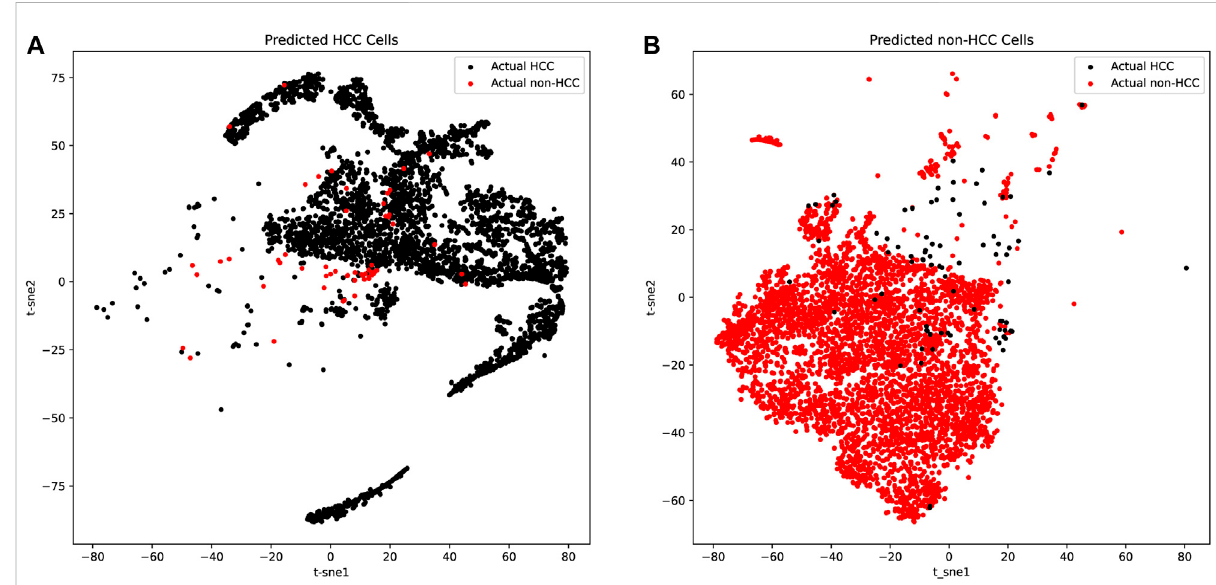
FIGURE 3 The t-SNE plots of predicted HCC cells and normal liver cells. (A) The t-SNE plots of predicted HCC cells. The true positive cells (black dots) accountforthevastmajority,whilethefalsepositivecells(reddots)occupiedonlyafewandwasmixedinthetruepositivecells,whichwasdif fi cultto distinguish. (B) Thet-SNEplotsofpredictednormallivercells.Thetruenegativecells(reddots)accountforthevastmajority,whilethefalsenegative cells (black dots) occupied only a few.